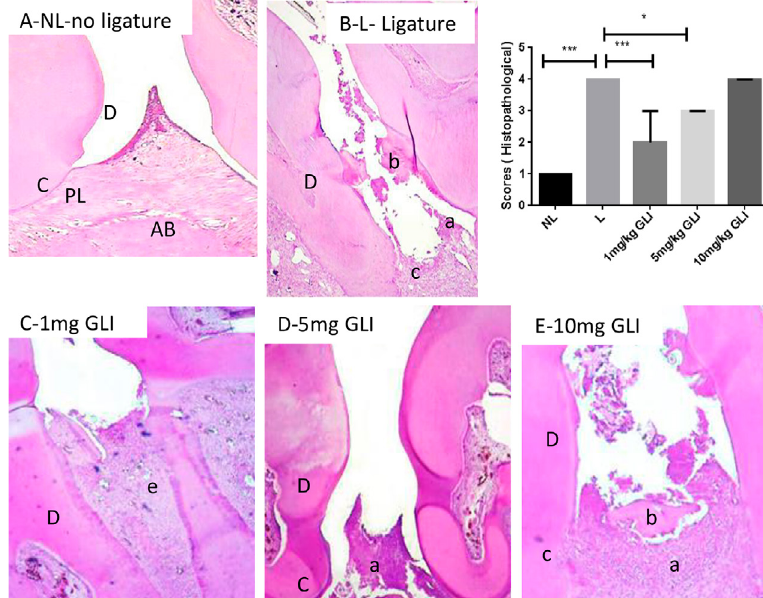
Figure 3- Histological analysis of maxillae from rats with periodontal disease. (A) Normal periodontium (no ligature group) showing alveolar bone integrity, absence of or only discrete cellular infiltration, and preserved alveolar bone. (B) Periodontium from a rat with periodontitis (ligature group) showing alveolar bone and cementum resorption (discontinuous cementum) and accentuated inflammatory cell infiltration. (C) Periodontium from a rat with periodontitis treated with 1 mg/kg gliclazide (GLI) showing reduced inflammation and decreased alveolar bone loss. (D) Periodontium from a rat treated with 5 mg/kg gliclazide showing moderate cellular infiltration. (E) Periodontium from a rat treated with 10 mg/kg gliclazide showing no reduced inflammation and increased experimental PD. PL, periodontal ligament; D, dentin; AB, alveolar bone; C, cementum; a, inflammatory process; b, bone loss; c, resorption of cementum; d decreased inflammation process. Sections were stained with hematoxylin and eosin. Original magnification, 40×. Histopathological scores. *p<0.05, **p<0.01, ***p<0.001